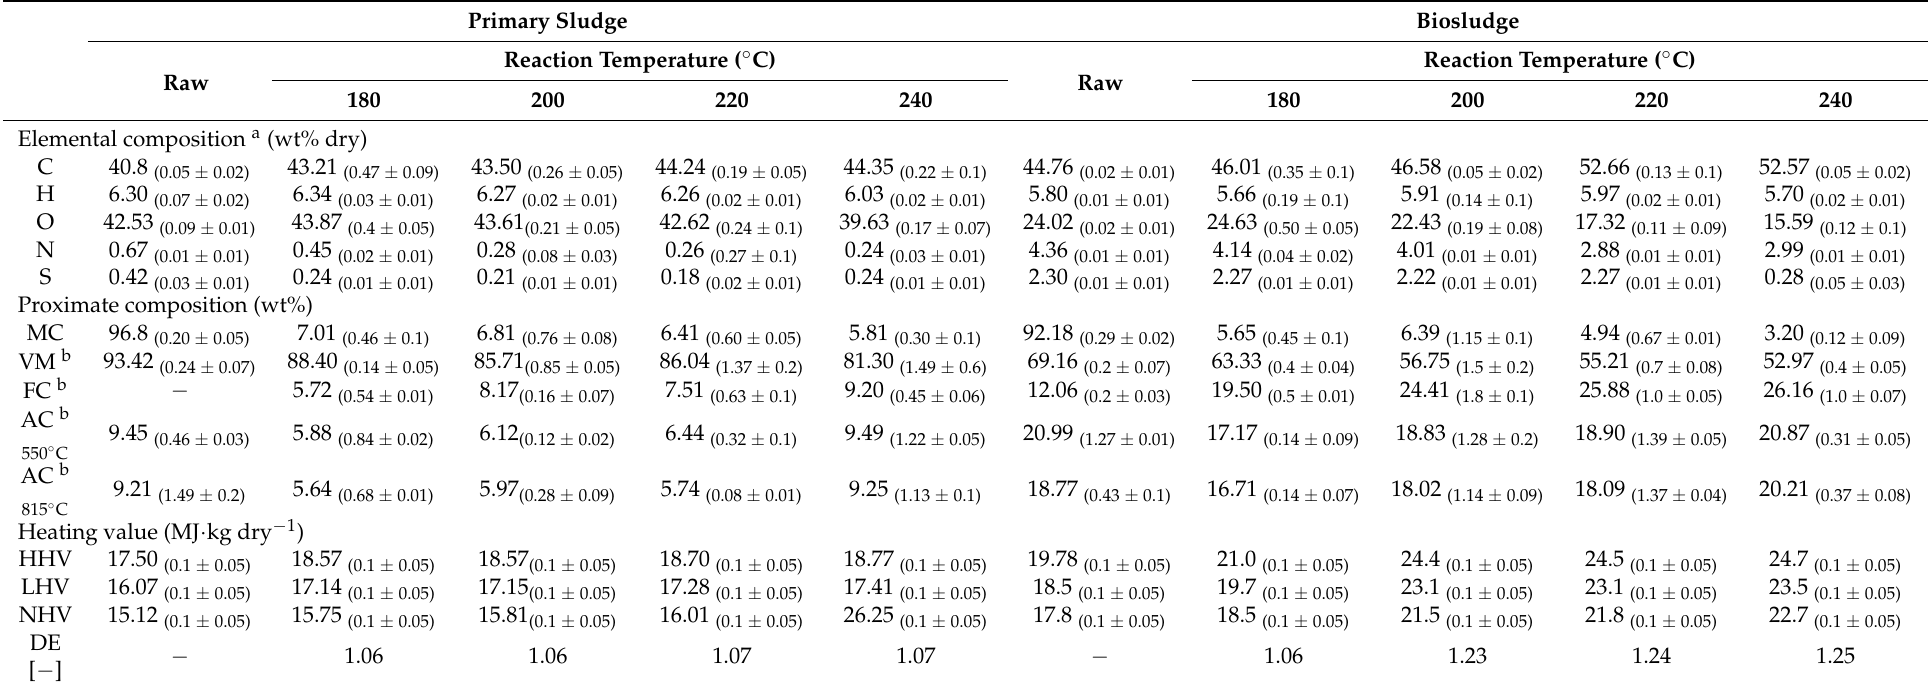
Table 1. Elemental, proximate, and heating value analysis of feedstock and hydrochar